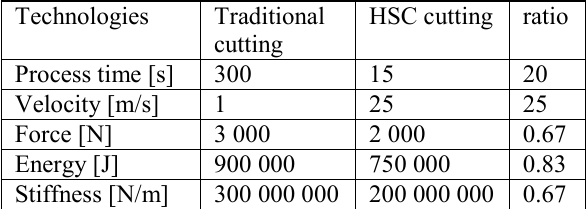
Table 4. Ratios between traditional cutting and